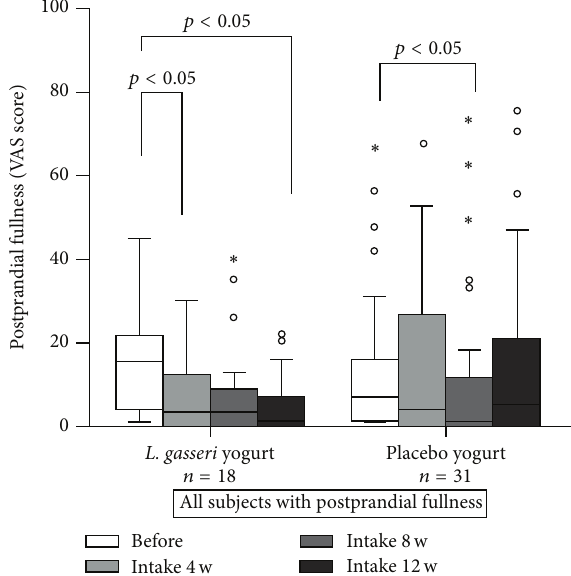
Figure 1: Changes in the severity score for postprandial fullness. Participants were asked to take Lactobacillus gasseri OLL2716- containing yogurt or placebo yogurt (control) once daily for 12 weeks, and the severity of dyspeptic symptoms was analyzed accord- ing to a visual analogue scale (VAS) as follows: 1, no symptoms; 10, severe pain, never experienced before. ∘ : less than 3 times the height of the box. ∗ : more than 1.5 times the height of the